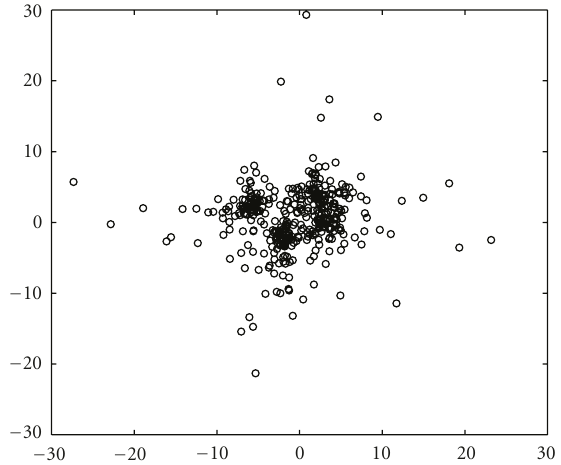
Figure 9: Data set for clustering example 1. Cauchy distributed samples with cluster centers [ − 6, 2], [ − 2, − 2], [2, 4], and [3, 0].